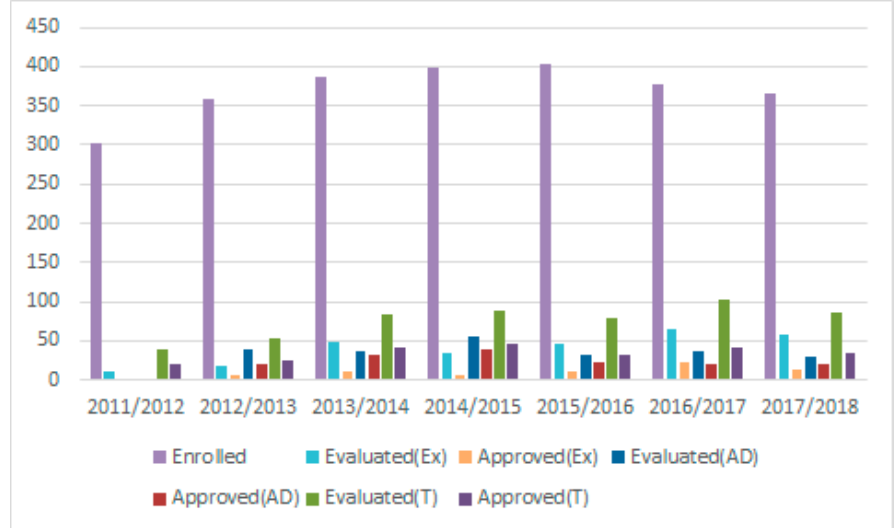
Mathematics 2021 , 9 , x FOR PEER REVIEW Figure 9. Pass rates distribution (AD, Ex, T): Informatics—1st semester. Figure 9. Pass rates distribution (AD, Ex, T): Informatics—1st semester.